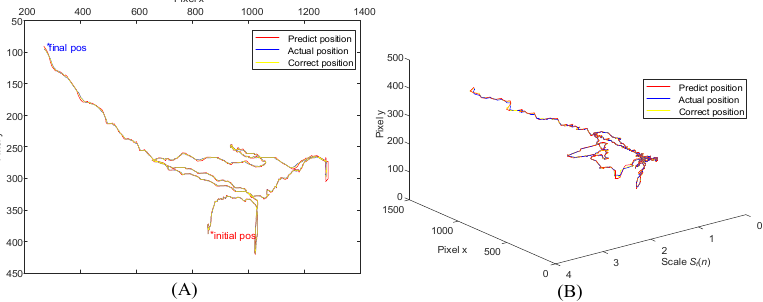
Figure 15. The position trajectory of the object. ( A ) The predicted, actual, and corrected positions in the plane. ( B ) The predicted, actual, and corrected positions in the 3D space; the depth is approxi- mately replaced by the target scale.